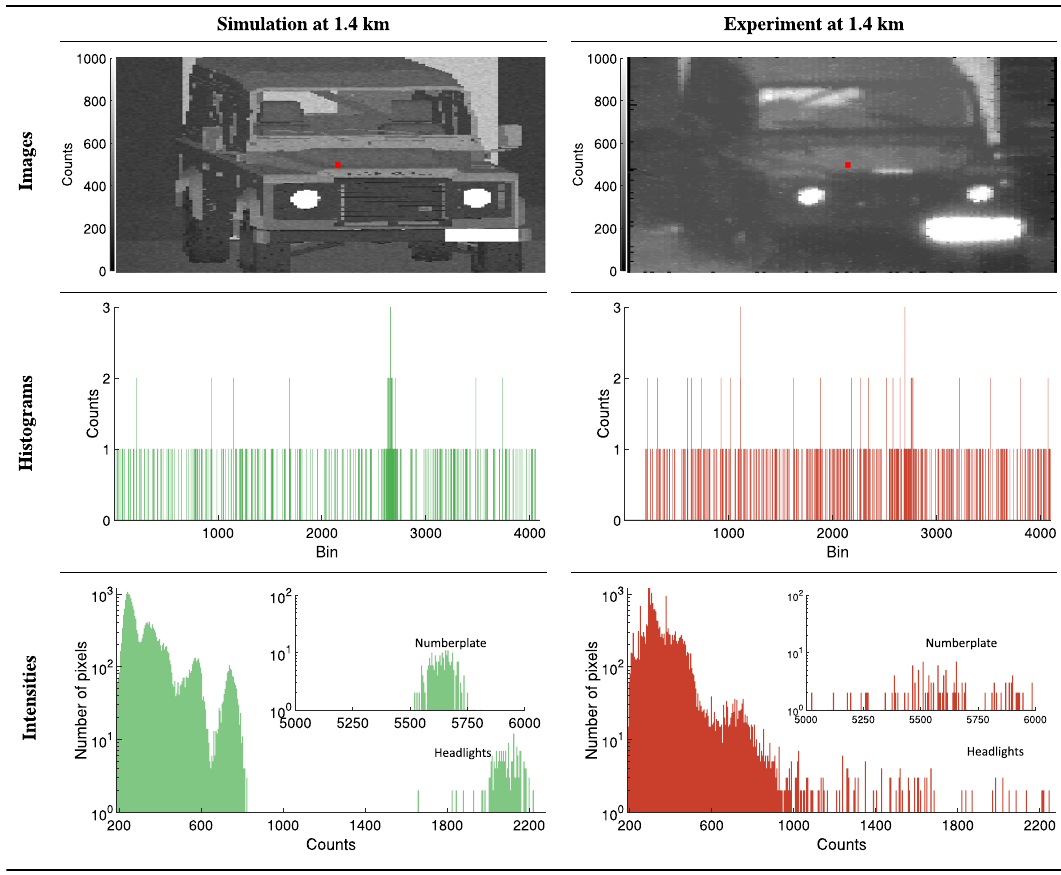
Figure 9. Quantitative and qualitative comparison between the simulated and measured intensity images for the Landrover. Top row; the simulated (left) and measured (right) intensity images. Middle row; the simulated (left) and measured (right) histograms for the pixel marked in red in the top row. Bottom row; the number of pixels (on a log scale) at a given intensity as a histogram for the simulated (left) and measured (right) results. The insets show the distribution at the high end of the counts (intensity) axis. Further, regions of notable intensity i.e., the numberplate and headlights have been